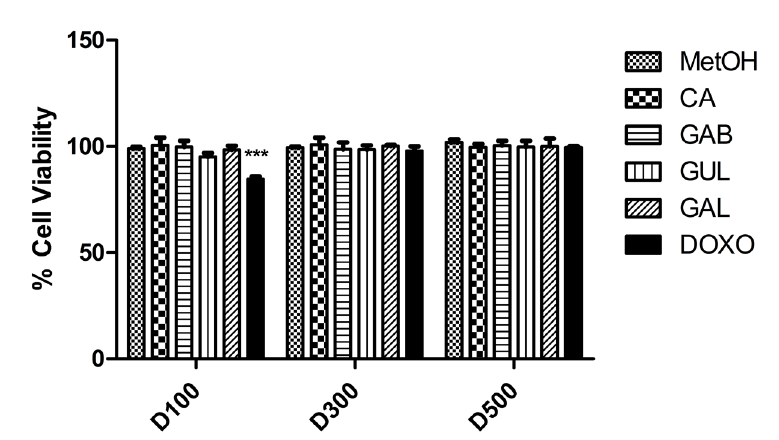
FIGURE 4 - Effect of Gauchito (GA) and Guri (GU) extracts on WISH human amnion cell viability. WISH human amnion cells were treated for 72h with dilutions 1:100 (D100), 1:300 (D300) and 1:500 (D500) of vehicle (MeOH, negative Control), GA or GU leaf extracts (GAL and GUL; D100 = 40 µg/mL, D300 = 13 µg/mL, D500 = 8 µg/mL), GA bracts (GAB D100 = 15 µg/mL, D300 = 5 µg/mL, D500 = 3 µg/mL), chlorogenic acid (CA, D100 = 10 µg/mL, D300 = 3.3 µg/mL D500 = 2 µg/mL). Doxorubicin (DOXO, D100 = 0.2 µg/mL; D300= 0.1 µg/mL and D500 = 0.05 µg/mL), was used as positive control. Cell viability was evaluated by MTS assay. Mean ± SD is represented for each sample. The asterisks indicate the existence of a significant difference between the extracts and control (** p < 0.01 and *** p < 0.001 ANOVA statistical test followed by Bonferroni’s post-test was